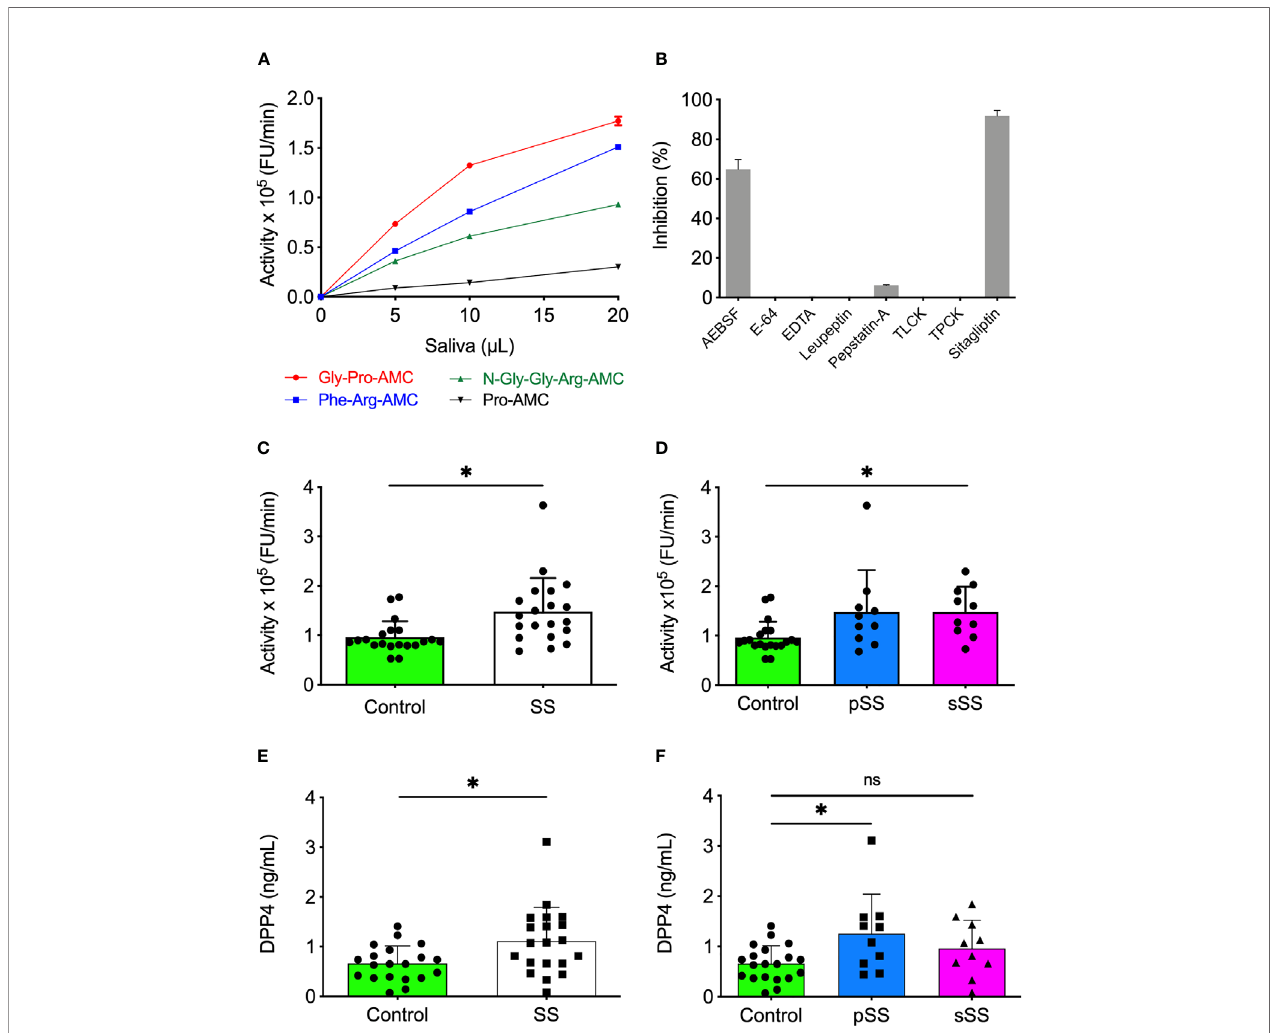
FIGURE 1 | Increased levels and activity of DPP4/CD26 in saliva of Sjögren ’ s syndrome individuals. (A) The SWS samples (10 µl) were incubated with each substrate (20 µM) in HEPES 25 mM (pH 7.5). (B) The SWS samples were incubated with Gly-Pro-AMC (20 µM) in HEPES 25 mM (pH 7.5) in the presence of classical protease inhibitors or sitagliptin. (C) Proteolytic activity of SWS individuals and (D) between SS groups using Gly-Pro-AMC (20 µM) in HEPES 25 mM (pH 7.5). (E) The DPP4/CD26 concentration was measured in all saliva samples and (F) between SS groups with the Human DPP4/CD26 DuoSet ELISA kit (R&D Systems, USA). All experiments were performed in triplicate. Data are expressed as the mean ± standard deviation. * p < 0.05; Student ’ s t -test. (D, F) One-way A- NOVA and Dunnett ’ s multiple comparison test. ns, not signi fi